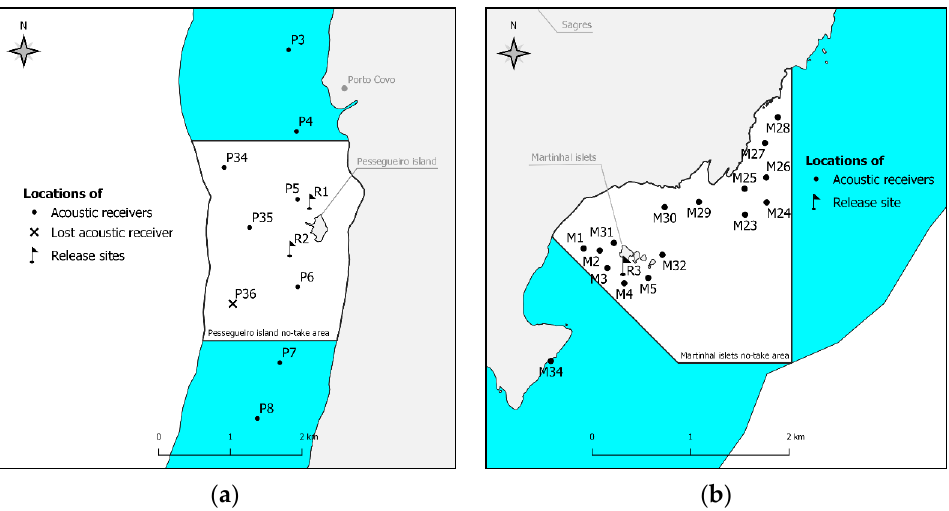
Figure 2. Acoustic biotelemetry receivers’ arrays used to track the dusky groupers in the ( a ) Pessegueiro island no-take area (total of 9 receivers) and ( b ) Martinhal islets no-take area (total of 16 receivers). Each acoustic receiver was identified with a letter (P — Pessegueiro island no-take area, M — Martinhal islets no-take area) and a number. Numbers assigned to the receivers are not neces- sarily in sequence and were independently attributed in the two arrays. Release sites were identified with the letter R and a number (R1, R2 in Pessegueiro island no-take area, and R3 in Martinhal islets no-take